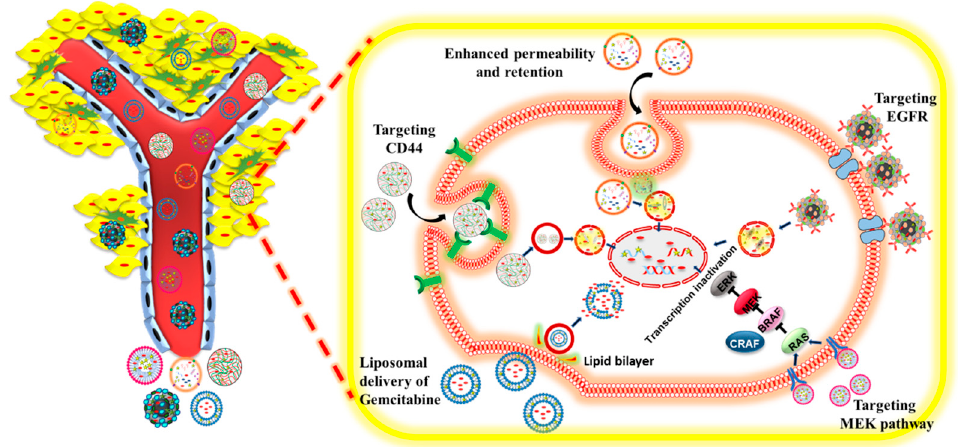
Figure 4. Passive (EPR) and active (ligand/receptor-based) targeting of Gemcitabine-based co- formulation. Table 2. Receptor-based targeting of Gemcitabine-based co-formulation designed using various polymers.